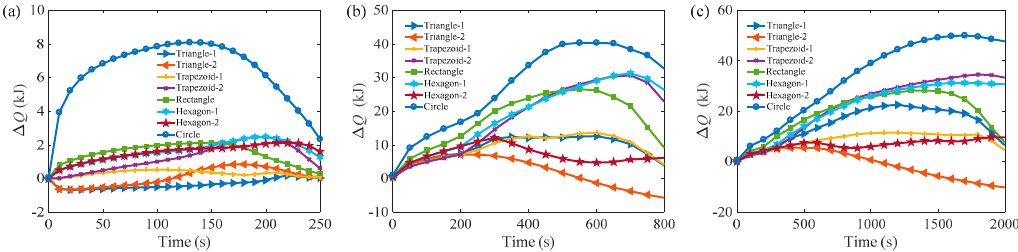
Energies 2019 , 12 , x FOR PEER REVIEW 16 of 18 Figure A3. Liquid fractions of the triangular, trapezoidal, rectangular, hexagonal, and circular cells with smaller aspect ratios ( AR = 0.5). ( a ) Ra = 4.83 × 10 6 ( A = 625 mm 2 ); ( b ) Ra = 3.87 × 10 7 ( A = 2500 mm 2 ).